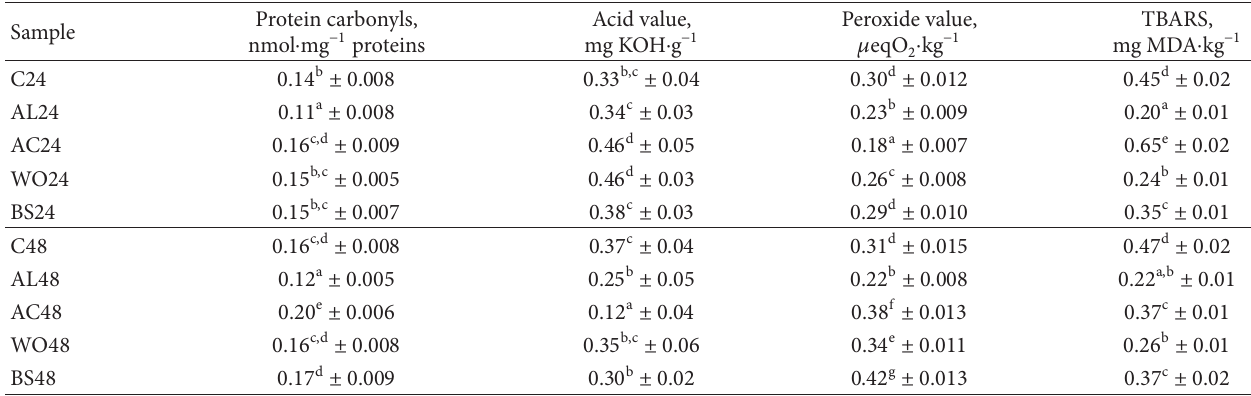
Table 2: Changes of the total protein carbonyls, acid value, peroxide value, and TBARS of the marinated sheep.